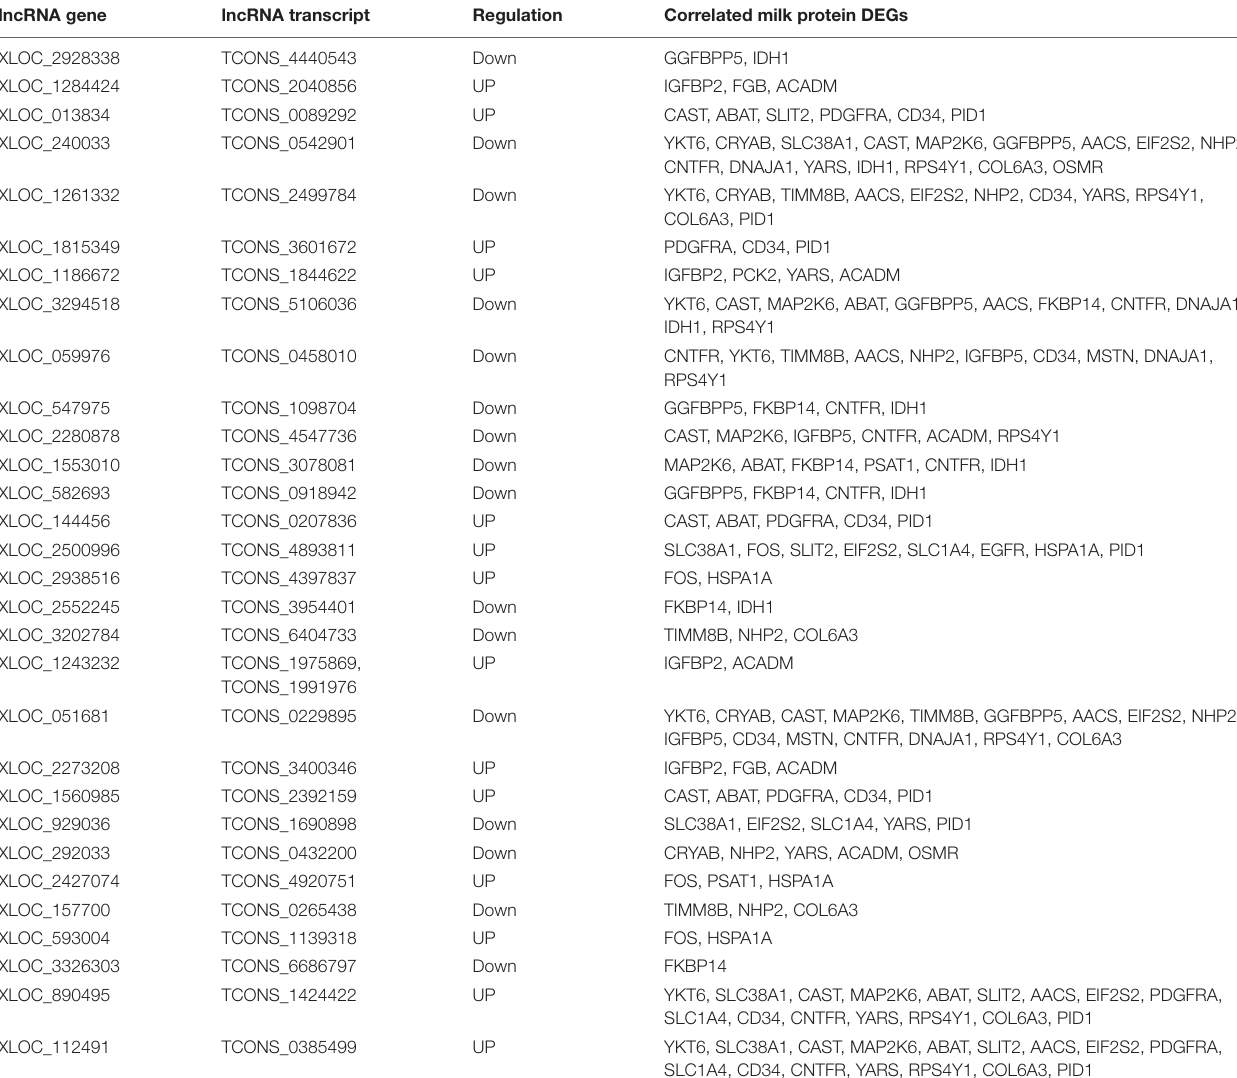
TABLE 3 | The differentially expressed lncRNAs with their potential target genes related to milk protein synthesis. lncRNA gene lncRNA transcript Regulation Correlated milk protein